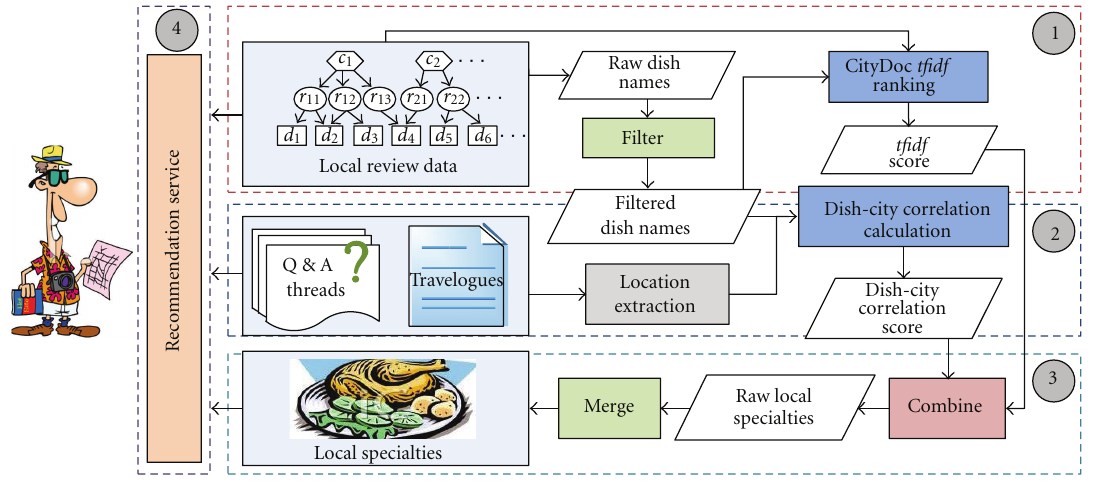
Figure 3: System